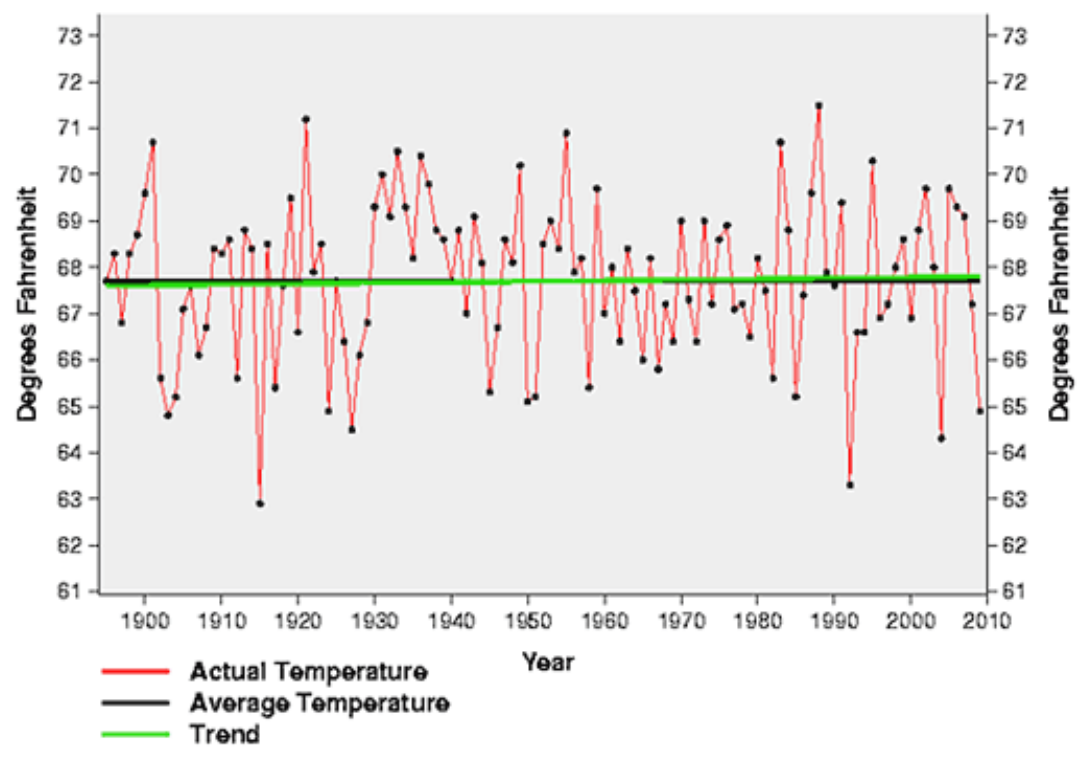
Figure 6. Mean summer (June- August) temperatures for the East North Central climatic region from 1895-2009 (from Taylor,